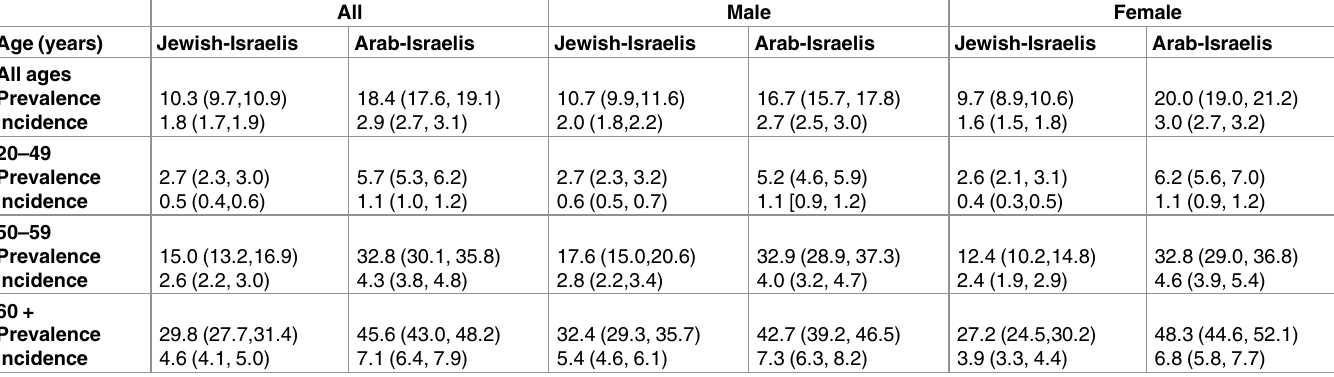
The age and sex-standardized diabetes cumulative 4-year incidence rates per 100 persons (95% confidence interval [CI] in parentheses) were higher among Arabs 2.9 (2.7–3.1) than among Jews 1.8 (1.7–1.9(, and were evident in all age groups (Table 2). While diabetes incidence rates were higher among Jewish males than among Jewish females, no similar difference was observed among Arab males and females (Table 2). Arabs had a much higher overall age- and sex-adjusted diabetes prevalence than Jews; 18.4 (17.6–19.1) and 10.3 (9.7–10.9), respectively. This ethnic difference was observed in all age- and sex-specific subgroups (Table 2). Unlike the sex differences in diabetes incidence, the prevalence of diabetes did not differ by sex among Jews. However, Arab females had a much higher prevalence of diabetes than Arab males; 20.0 (19.0–21.2) vs. 16.7 (15.7–17.8), respec- tively. This female preponderance was observed mainly among Arabs (cid:21) 60 years old (Table 2). The HRs for diabetes among younger Arabs (age 20–49 years) were 2.04 (95% CI, 1.74– 2.40) and 1.56 (95% CI, 1.34–1.81) in older participants (age (cid:21) 60 years), (Table 3). Adjust- ment for the MetS components mildly attenuated the HR estimates associated with Arab Table 2. Standardized and age-specific prevalence and weighted cumulative 4-yr incidence per 100 persons of diabetes (95% confidence interval) * . All Male